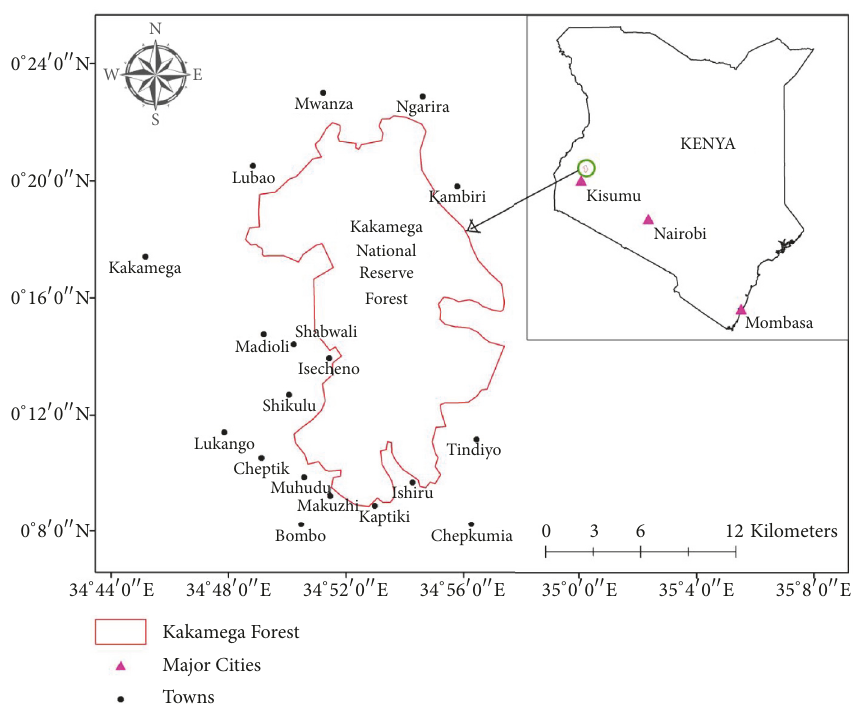
Figure 1: Map of the Kakamega National Reserve